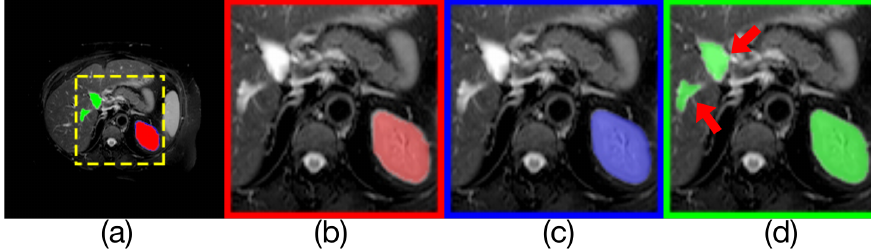
Figure 12. Comparison of model outputs and ground truth. ( a ) is composed of the other three figures above stacked from top to bottom, where the predicted extra areas are clearly seen. The red area in ( b ) is the manually annotated result. The blue region in ( c ) is the output of Render U-Net. The green region in ( d ) is the output of UNet++. Some areas with incorrect predictions are indicated with red arrows in the